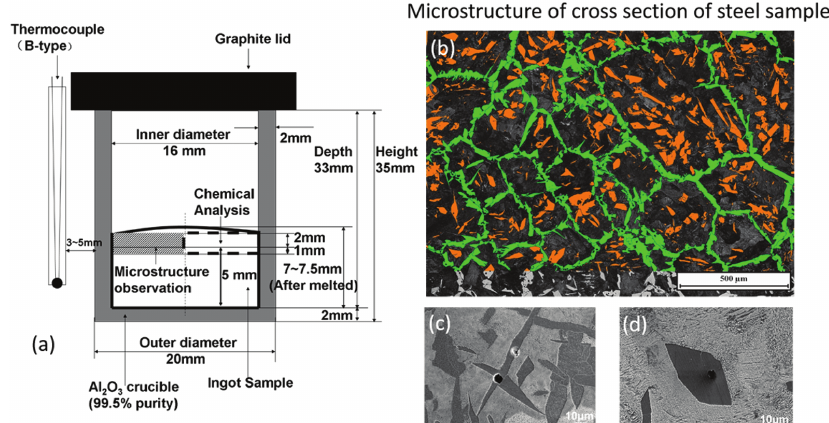
Figure 4: Illustrations of (a) cutting posi- tions for microstructure observation and chemical analysis, (b) microstructure of cross section in the steel sample with TiN particles additions, and (c) and (d) different morphologies of IGF, reported by the present authors [8].